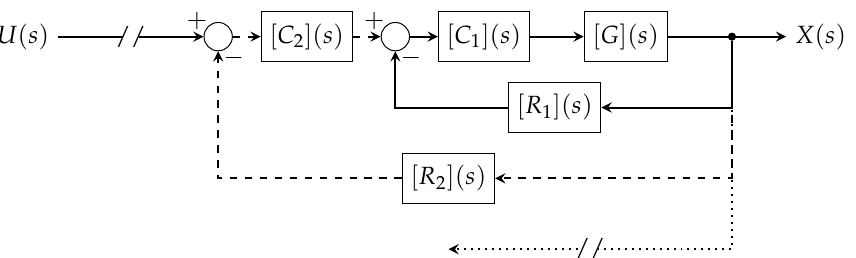
Figure 4. Example of the generic control loop structure for the type of system discussed in this